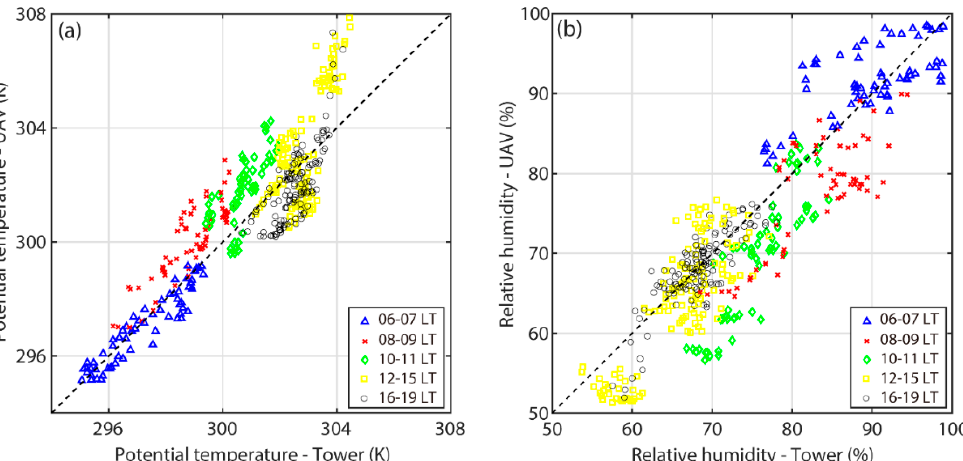
Figure 3. Scatter plots of ( a ) potential temperature and ( b ) relative humidity between tower and UAV observations at 06–07 (blue triangle), 08–09 (red cross), 10–11 (green diamond), 12–15 (yellow square), and 16–19 LT (black circle). Table 2. Correlation coefficients (R) of potential temperature and relative humidity between tower